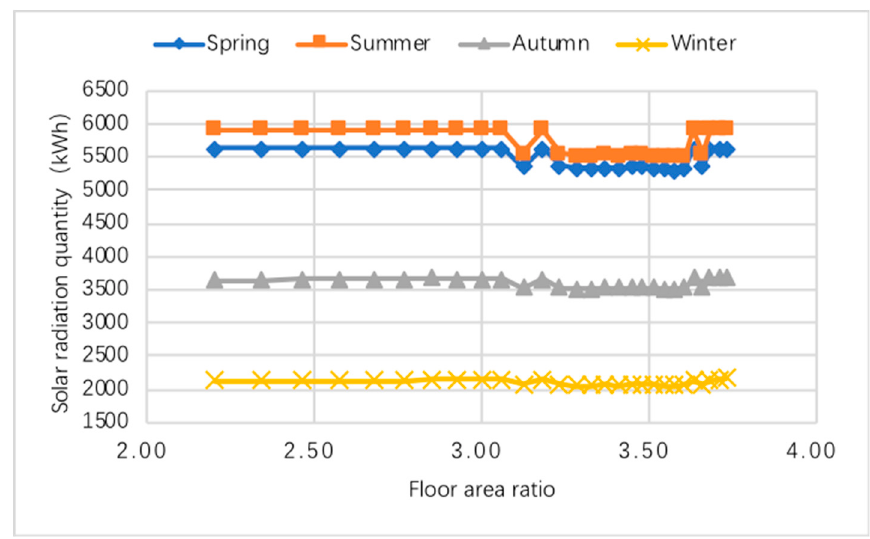
Figure 4. Solar radiation analysis of each season.